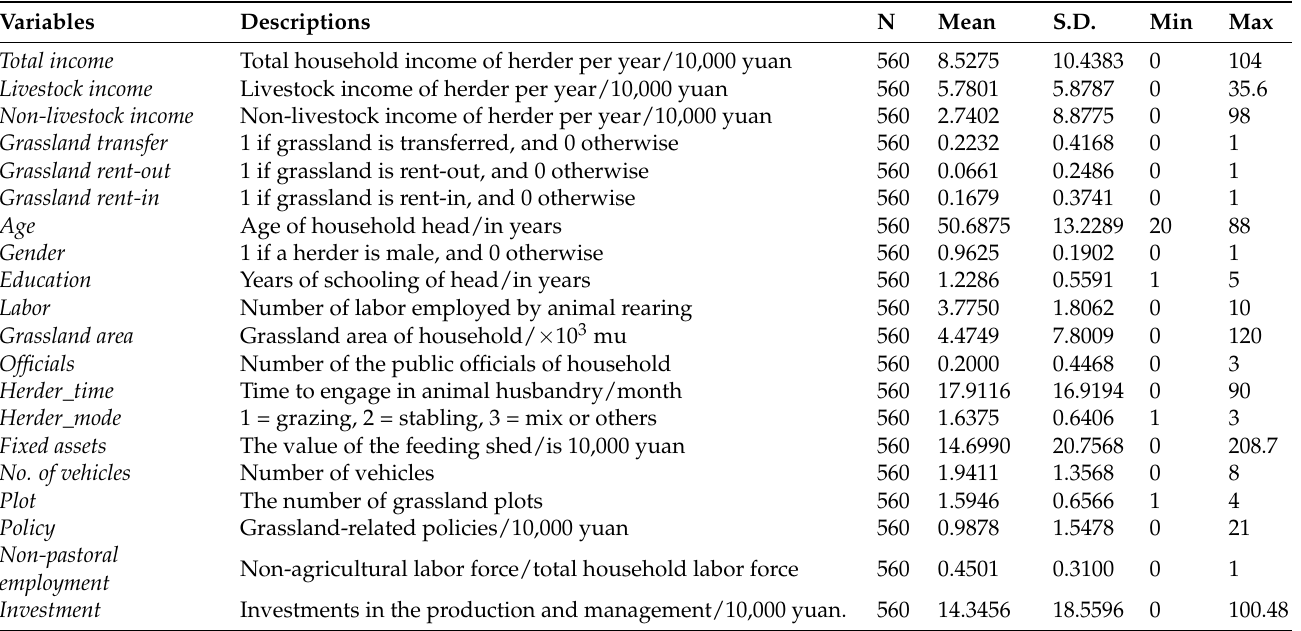
Table 1. Descriptive statistics of all